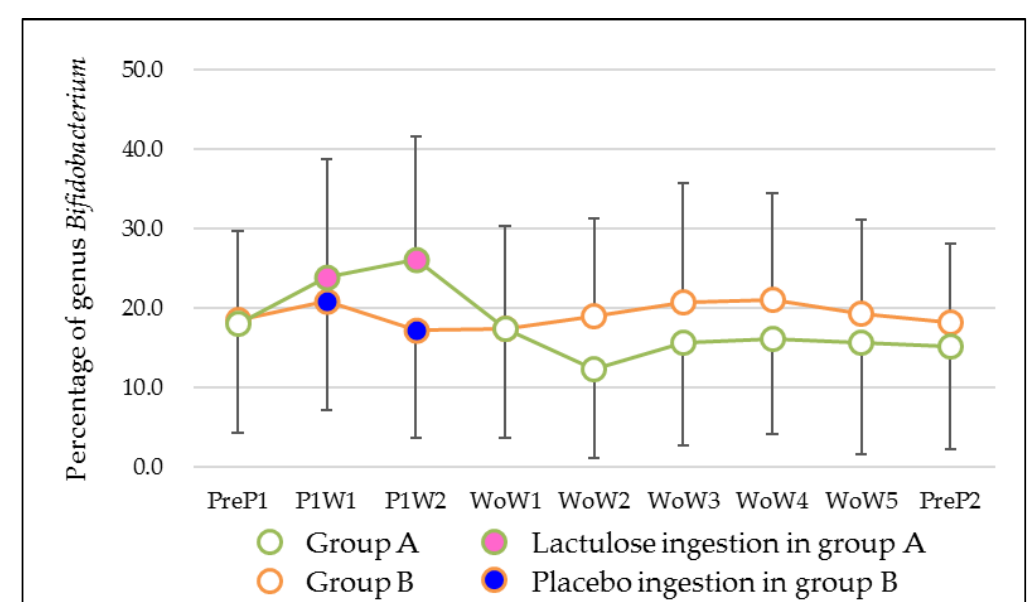
Figure A3. Transition in the percentages of genus Bifidobacterium in the faecal microbiome in a